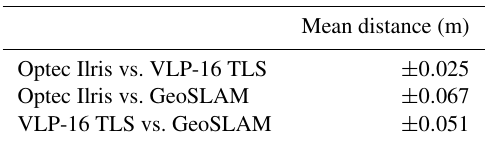
Table 7. Mean distance between Ilris, GeoSLAM and Velodyne TLS (M3C2